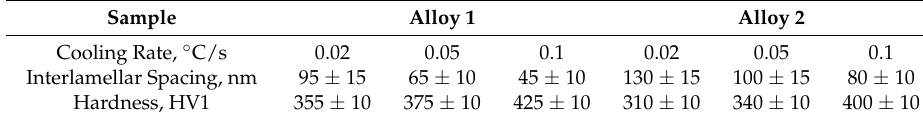
Table 2. Relationship between cooling rate and lamellar spacing or hardness.